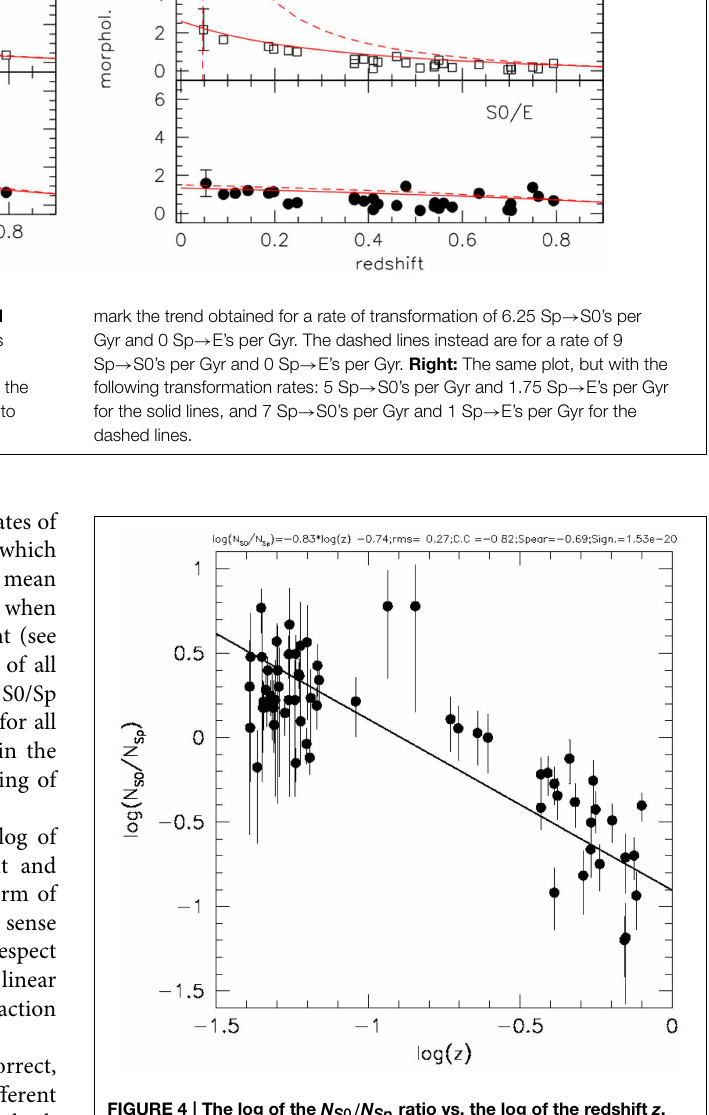
FIGURE 4 | The log of the N S 0 / N Sp ratio vs. the log of the redshift z . The solid line gives the best fit. Poissonian error bars mark the 1 σ uncertainty of the observed